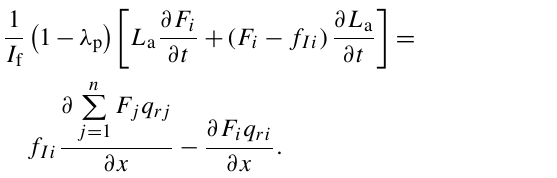
also described by an exponential function of time, in anal- ogy to Eq.